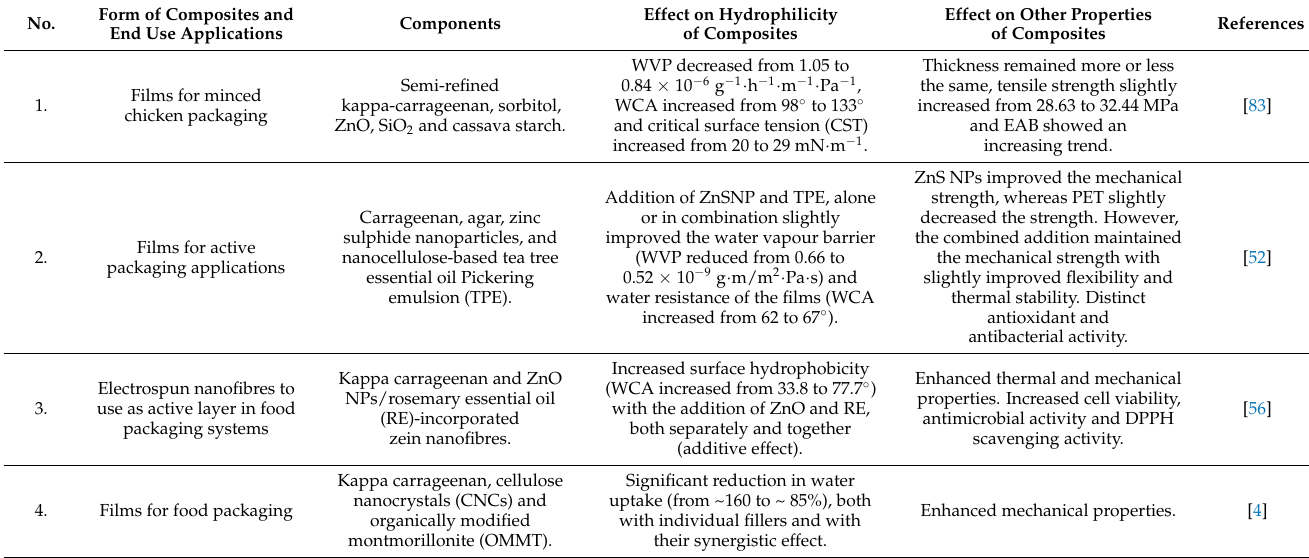
Table 12. Synergistic effects of various fillers in carrageenan-based